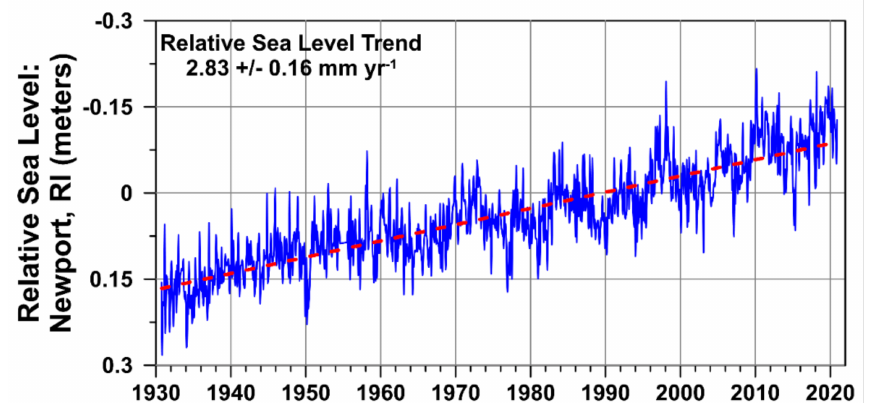
Figure 2. Monthly average sea-level at the Newport, RI tide gauge (blue line). The red dashed line is a linear fit through the data [36].